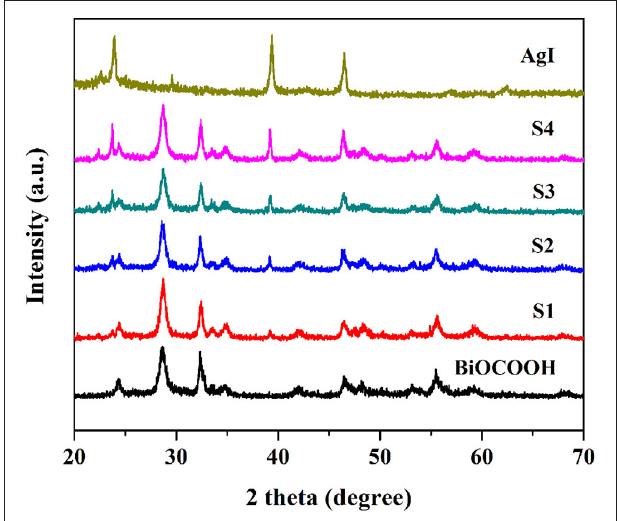
FIGURE 1 | XRD patterns of AgI/BiOCOOH heterojunctions (S1, S2, S3, and S4), pristine BiOCOOH and AgI.